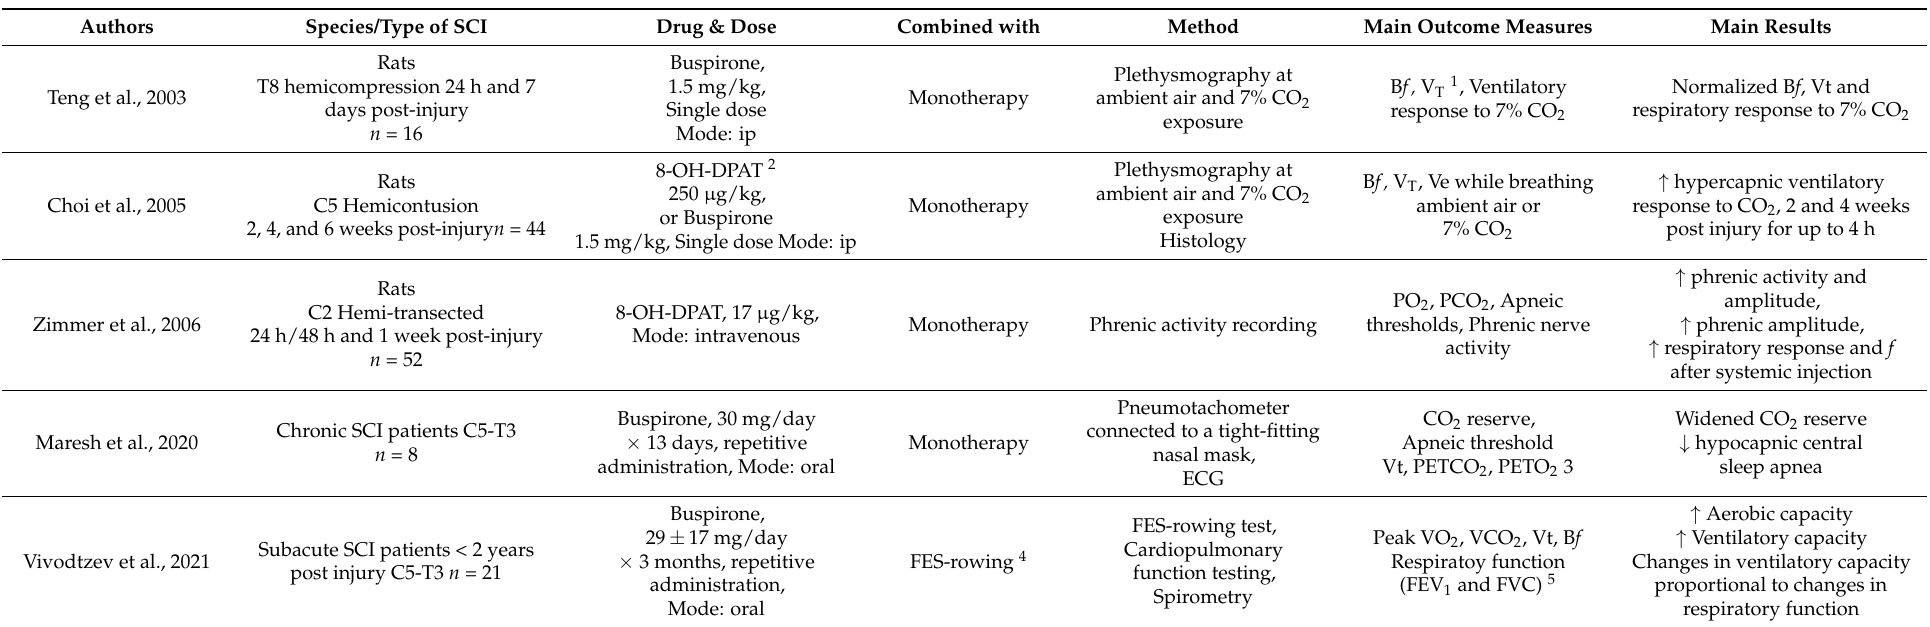
Table 2. Respiratory effects of 5-HT 1A agonists in animals and